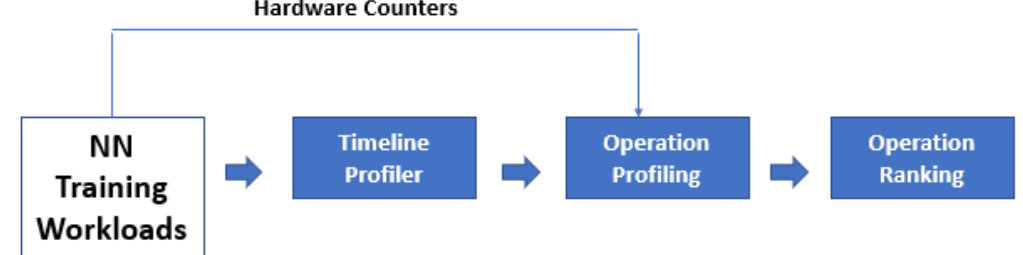
Figure 32. The proposed runtime framework in [17].